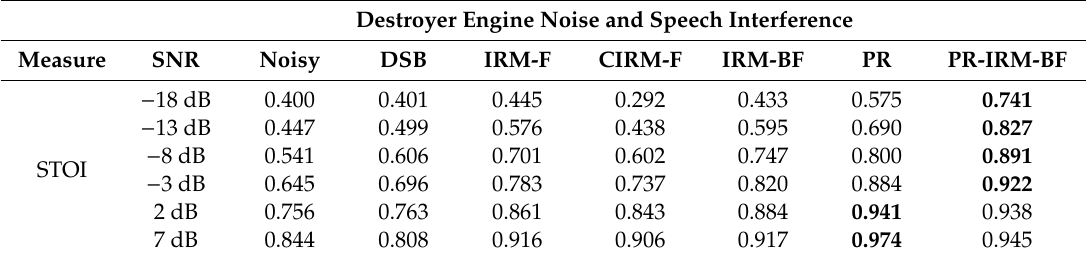
Table 2. The average performance of the system in five mixed noise